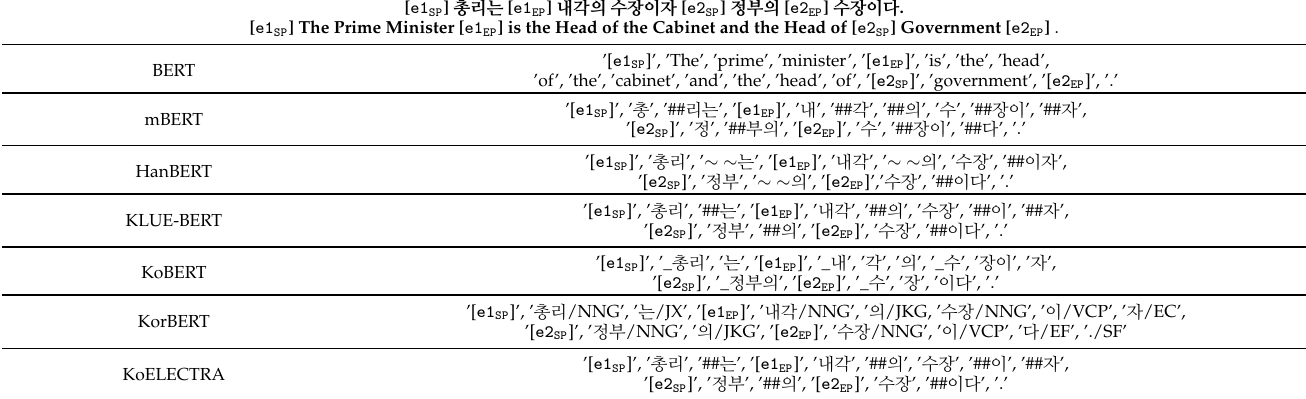
Table 2. Comparison on the results of tokenization from each model. #, ∼ , and _ denote the boundary symbol of each